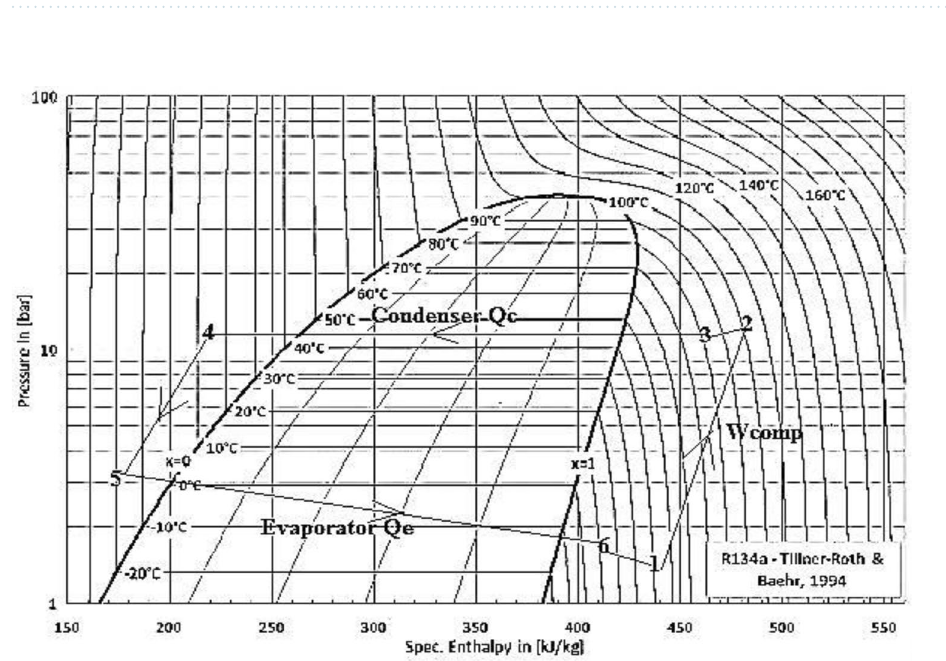
Table 2. Characteristics of R134a 42 .